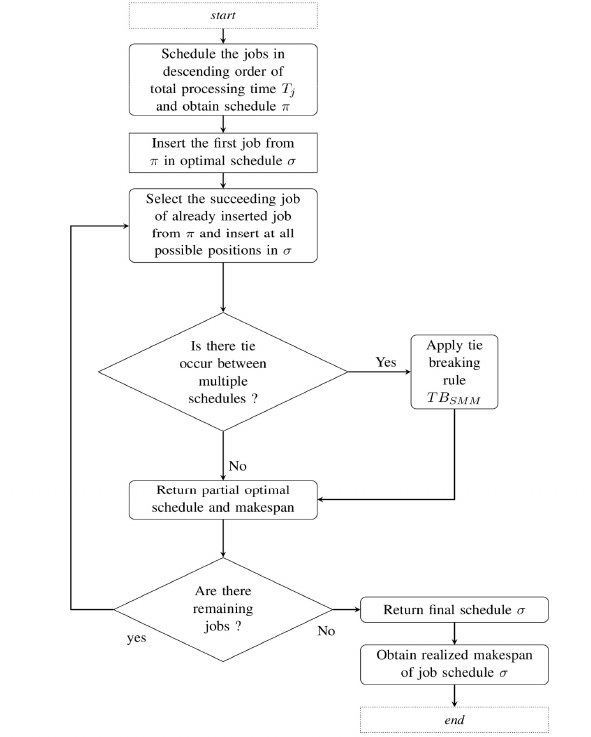
Fig. 1. Flow chart of proposed